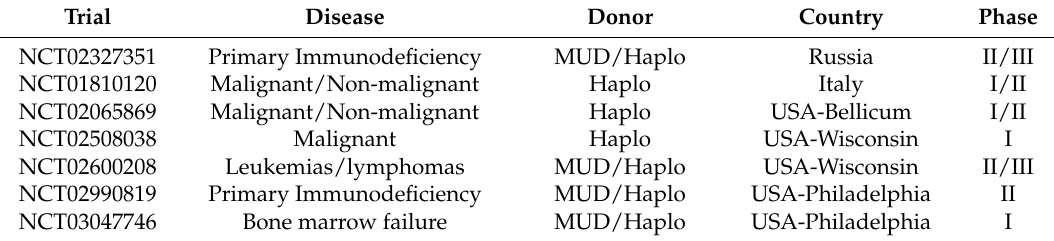
Table 2. Selected ongoing clinical trials of αβ T cell depletion (all are pediatric studies). Trial